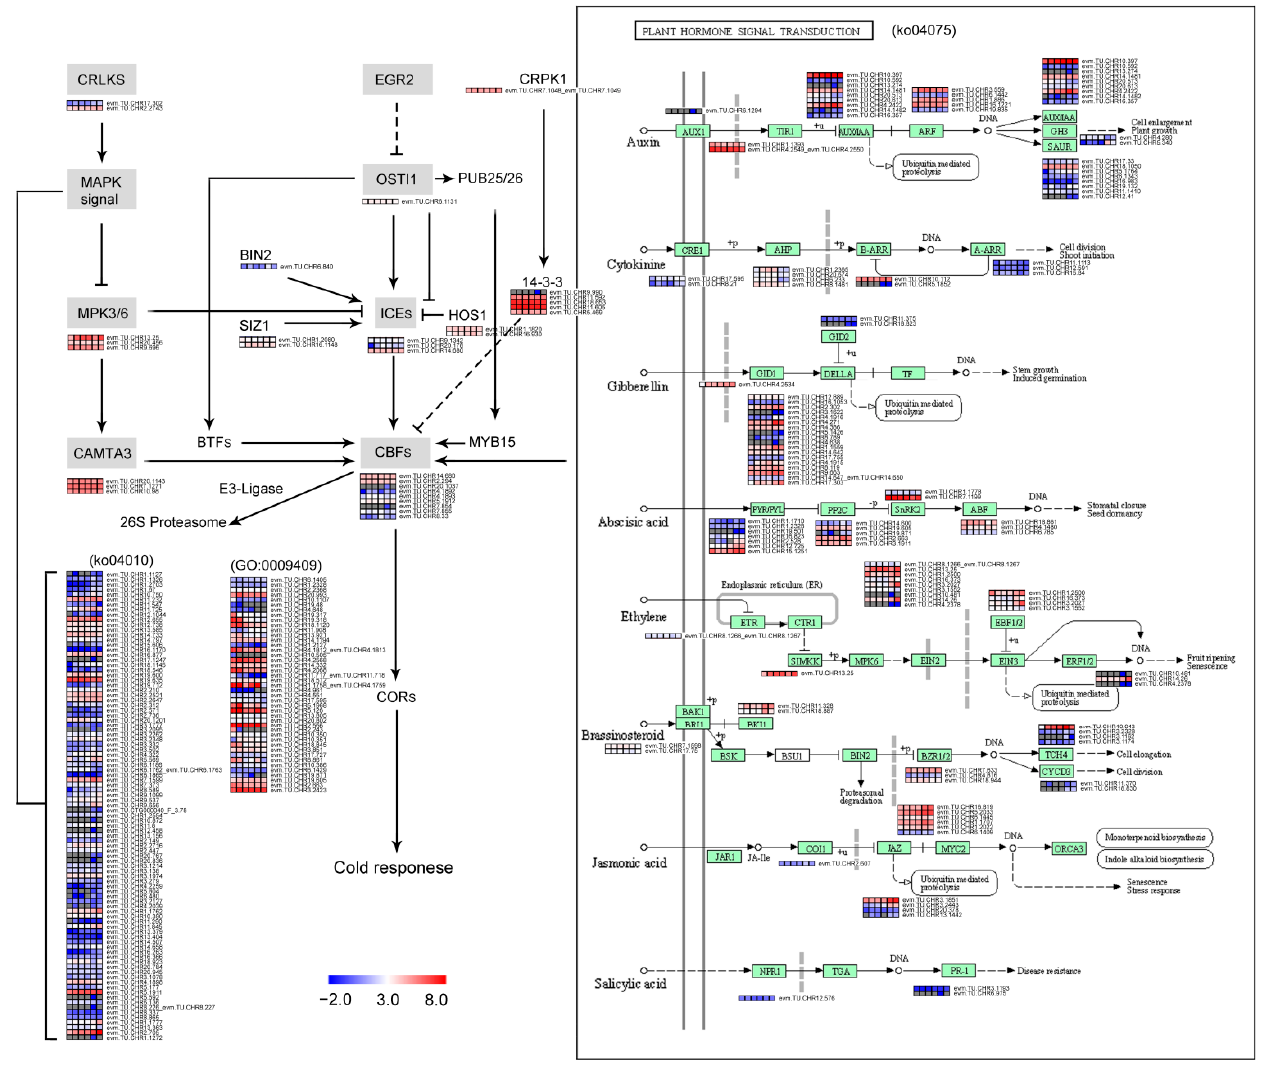
Figure 5. Expression of genes related to response to cold stress in I. dabieshanensis . The original figure is from Hwarari’s figure, and it was modified according to our results. The squares in each column of the heatmap represent cold treatment at 0 h (CK), 3 h, 6 h, 9 h, 12 h, and 24 h, respectively, from left to right.